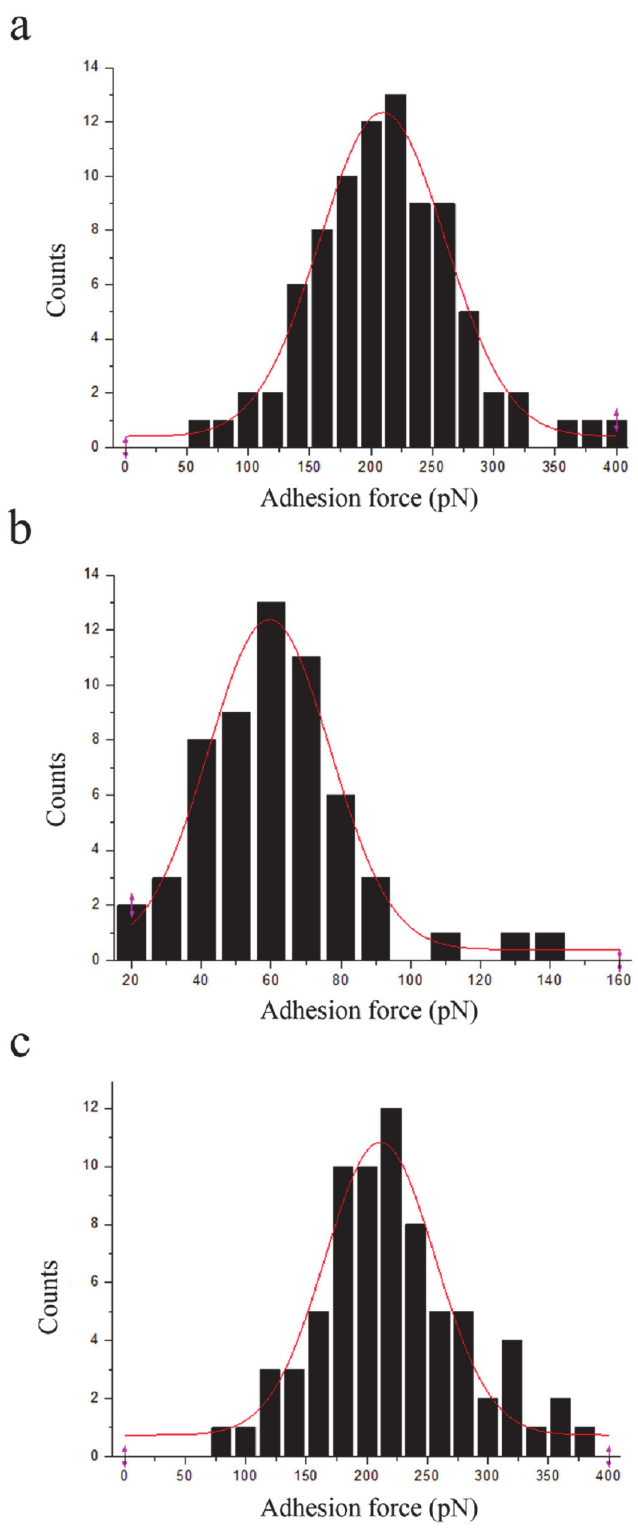
Fig 4. Adhesion force histograms with fitting Gaussian (red line) of ligands to EGFR immobilized surface. (a) EGF to EGFR. (b) GE11 to EGFR. (c) mAb to EGFR.